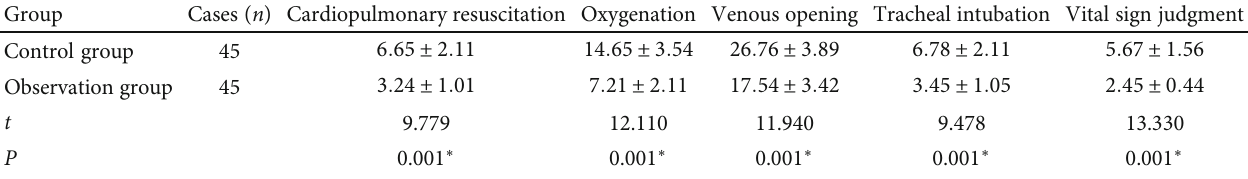
Table 1: Comparison of resuscitation time of patients in 2 groups (( (cid:1) x ± s ), min). Group